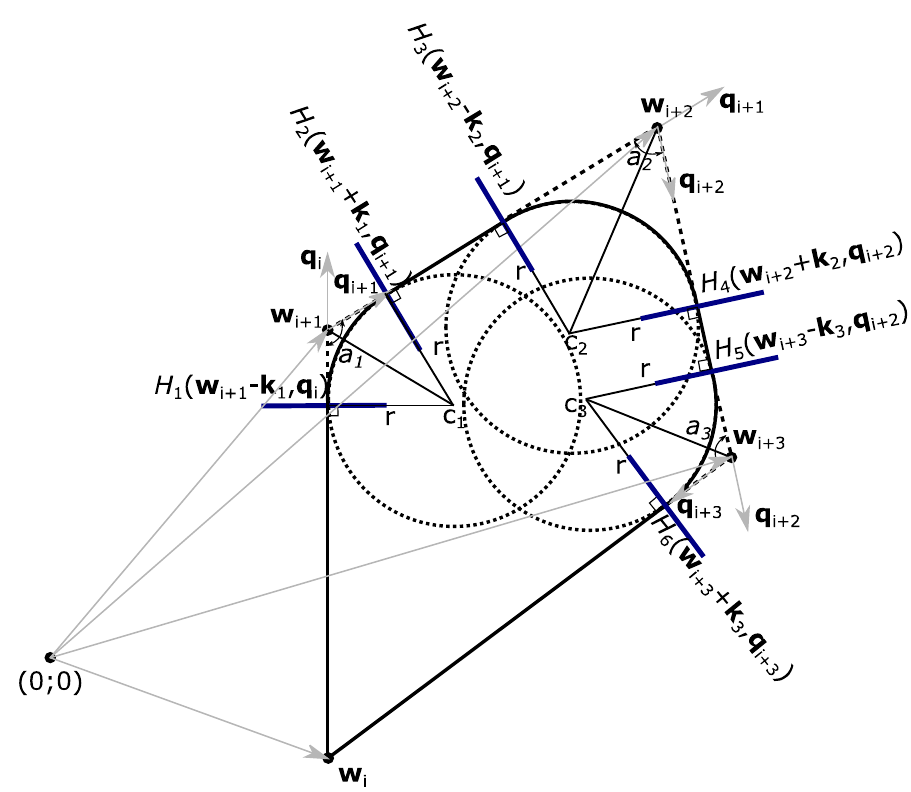
Figure 1. Conversion of a simple UAV mission into a Dubins trajectory.